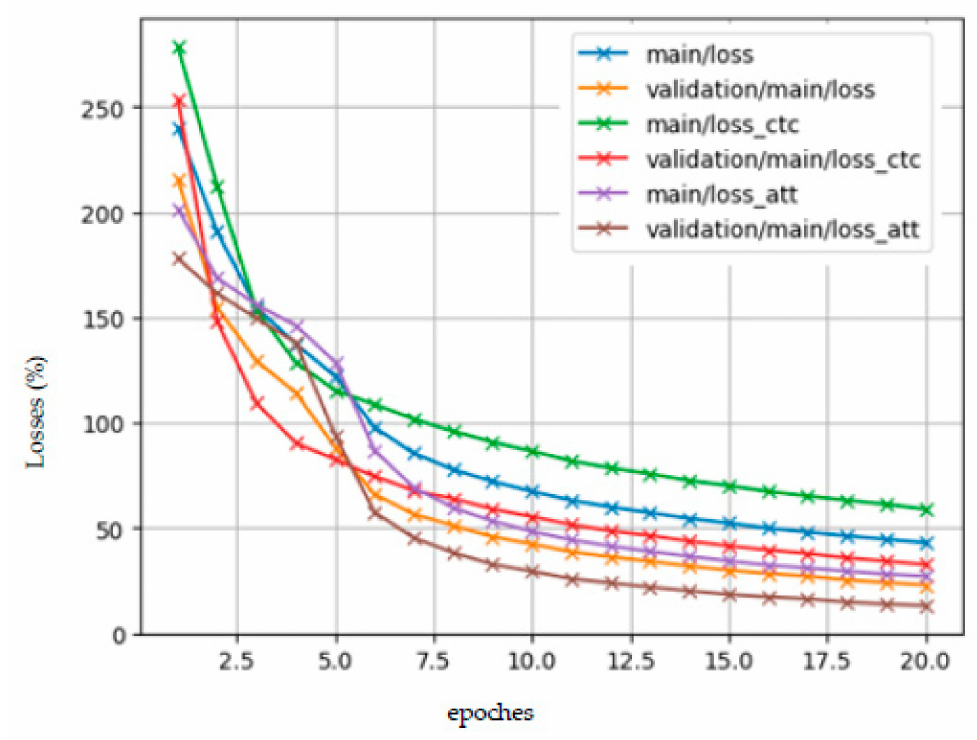
Figure 6. Phoneme‑based CTC‑attention with SpecAugment loss